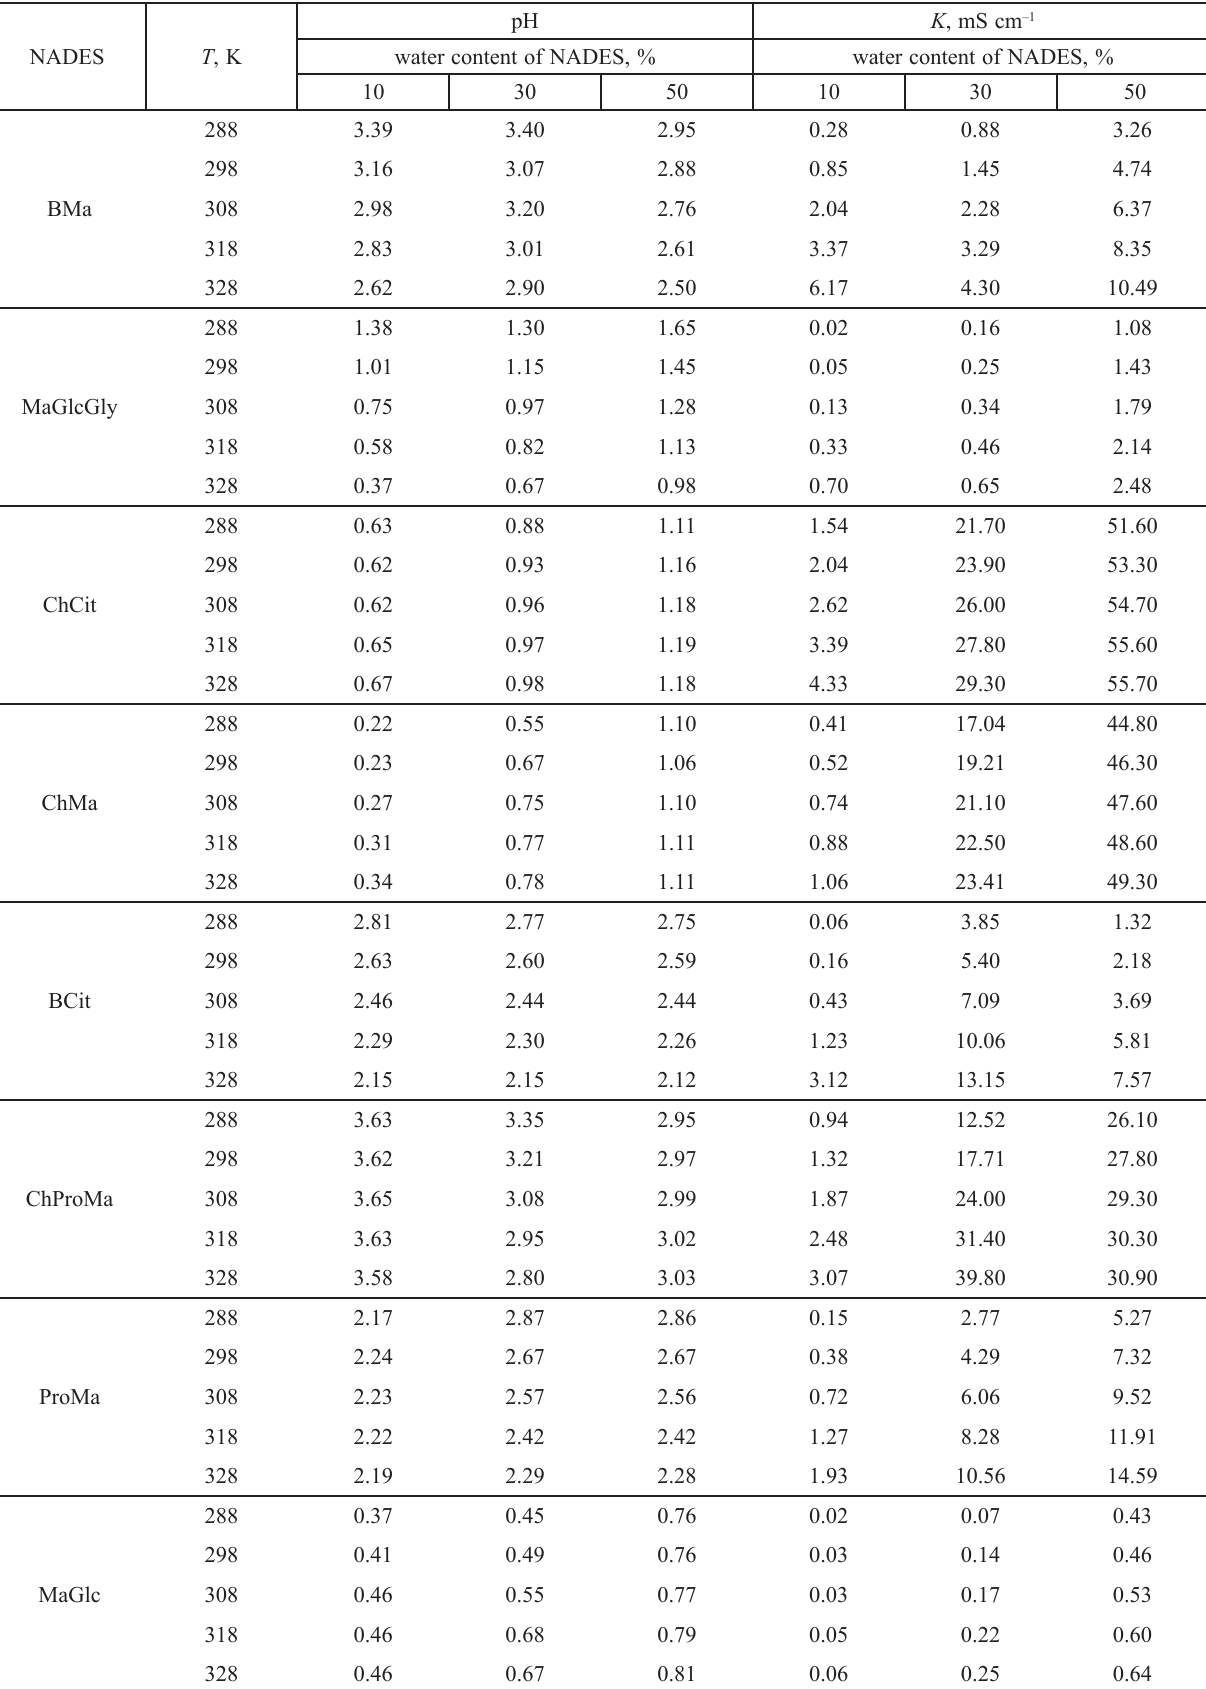
Table 3 – pH values and conductivity of NADES with different water contents 10–50 % (w/w) in temperature range 288–328